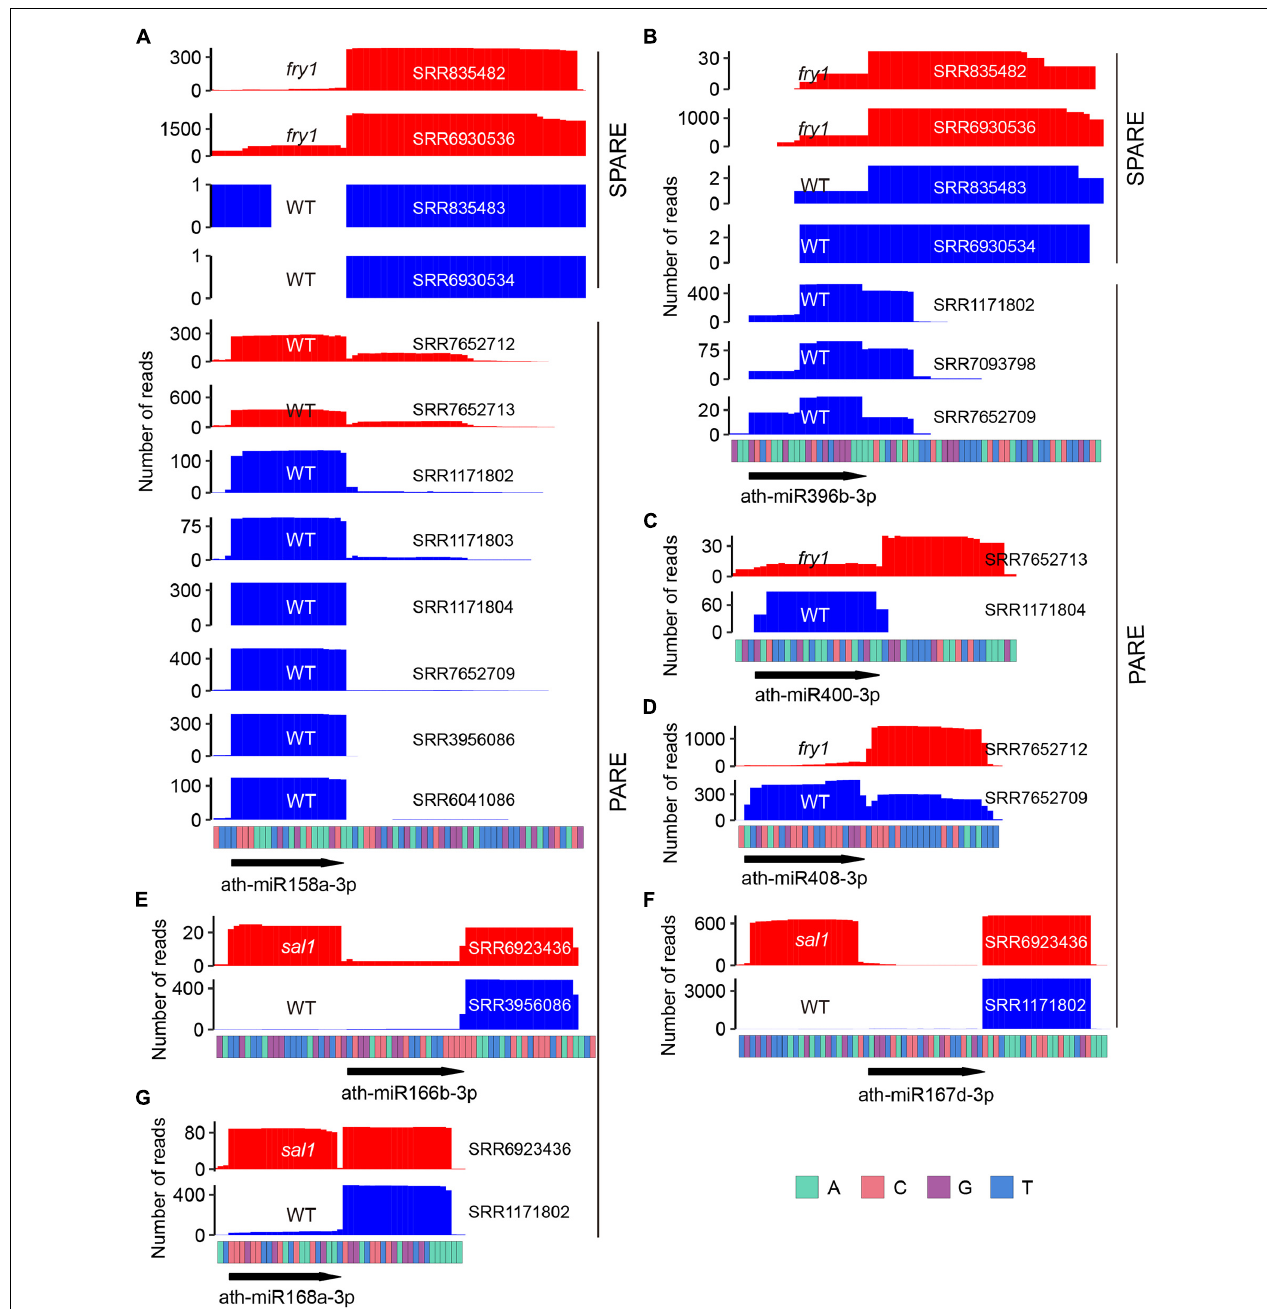
FIGURE 4 | fry1 / sal1 impacts miRNA processing. (A) Specific Parallel Amplification of RNA Ends (SPARE) and Parallel Amplification of RNA Ends (PARE) profiles of ath-miR158a-3p in fry1 (red) and Wt (blue). (B) SPARE and PARE profiles of ath-miR396b-3p in fry1 (red) and Wt (blue). (C,D) PARE profiles show that the processing modes of ath-miR400 (C) and ath-miR408 (D) changed from short loop-to-base to short base-to-loop in fry1 . (E–G) PARE profiles show that the processing modes of ath-miR166b (E) , ath-miR167d (F) , and ath-miR168a (G) changed from short base-to-loop to short/sequential loop-base in sal1